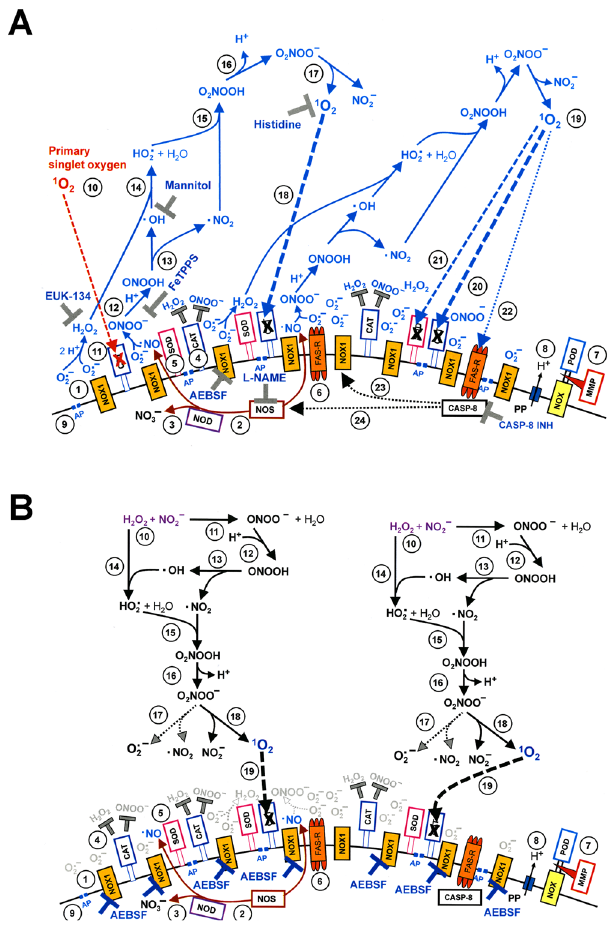
Figure 10. Redox reactions on the surface of tumor cells. ( A ) Biochemistry of secondary singlet oxygen generation. NADPH oxidase 1 (NOX1) is expressed in the membrane of malignant cells and generates extracellular superoxide anions (#1). NO synthase (NOS) (#2) generates ⋅ NO which can be either oxidised by NO dioxygenase (NOD) (#3) or pass through the cell membrane. Membrane-associated catalase (#4) protects tumor cells towards intercellular ROS/RNS-mediated signaling. Comodulatory SOD (#5) is required to prevent superoxide anion-mediated inhibition of catalase. Further important elements in the membrane are the FAS receptor (#6), Dual oxidase (DUOX) (#7), from which a peroxidase domain is split through matrix metalloprotease, proton pumps (#8) and aquaporins (#9). Primary singlet oxygen from an exogenous source (such as a photosensitizer, long-lived species from PAM or 1 O 2 derived from CAP) causes local inactivation of catalase (#10). As a consequence, tumor cell-derived H 2 O 2 (#11) and ONOO − (#12) are no longer decomposed at the site of inactivated catalase and allow the subsequent generation of secondary singlet oxygen through reactions # 13-#17. These have autoamplificatory potential, as further singlet oxygen-mediated inactivation of catalase (#18) allows for more generation of secondary singlet oxygen (#19). In addition to inactivating catalase (#20), secondary singlet oxygen may inactivate SOD (#21) or activate the FAS receptor independent of its ligand (#22). This causes caspase-8-dependent enhancement of NOX1 and NOS activities. As a result, the generation of secondary singlet oxygen is further enhanced. Figure 10 A also shows the site of action of established inhibitors and scavengers that have been instrumental for the elucidation of the biochemistry of signaling. ( B ) Detection of catalase inactivation by primary singlet oxygen generated from long-lived species in plasma-activated medium. #1-#9 shows redox biology related elements of tumor cells, with the focus on the membrane, as described under A. In order to be able to detect inactivation of membrane-associated catalase by primary singlet oxygen generated from long-lived species present in PAM, i) the generation of secondary singlet oxygen by tumor cells has to be prevented through AEBSF-mediated inhibition of NOX1 and ii) the effective dose of primary singlet oxygen ( 1 O 2 ) needs to be brought to a substantial level. The increase in the generation of primary singlet oxygen ( 1 O 2 ) is symbolized by the twofold reaction scheme for its generation. Primary 1 O 2 generated through the interaction between H 2 O 2 and nitrite (#10) is based on reactions #11-#18. Please note that the generation of primary singlet oxygen shows a strong mechanistic overlap (reactions # 12-#18) with the generation of secondary 1 O 2 as outlined under A. Inactivation of a substantial concentration of membrane- associated catalase by primary singlet oxygen can be detected through sensitization of the tumor cells for a challenge with exogenous ONOO − , as determined in the experiment described in Fig.